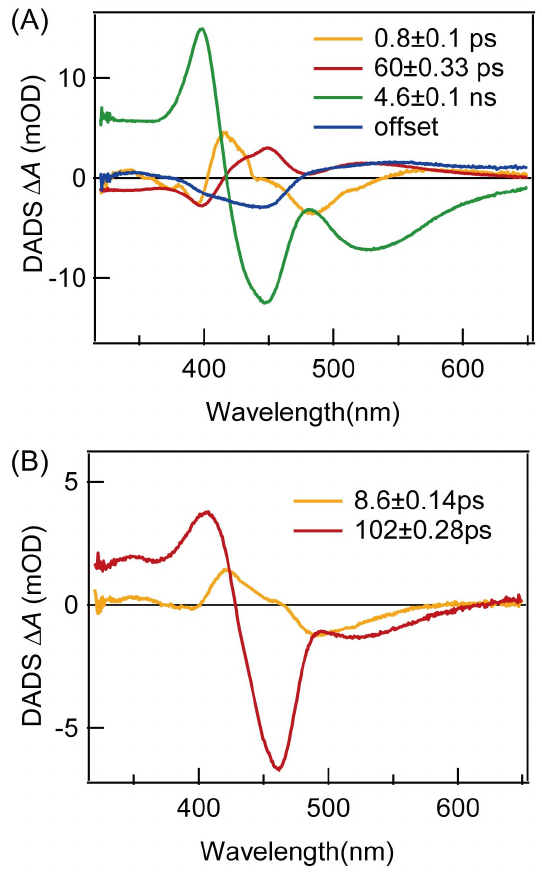
Figure 4. Decay-associated difference spectra (DADS) extracted from the global fitting of TA data for ( A ) proflavine and ( B ) PF − DNA in buffer solution (pH = 7.4).